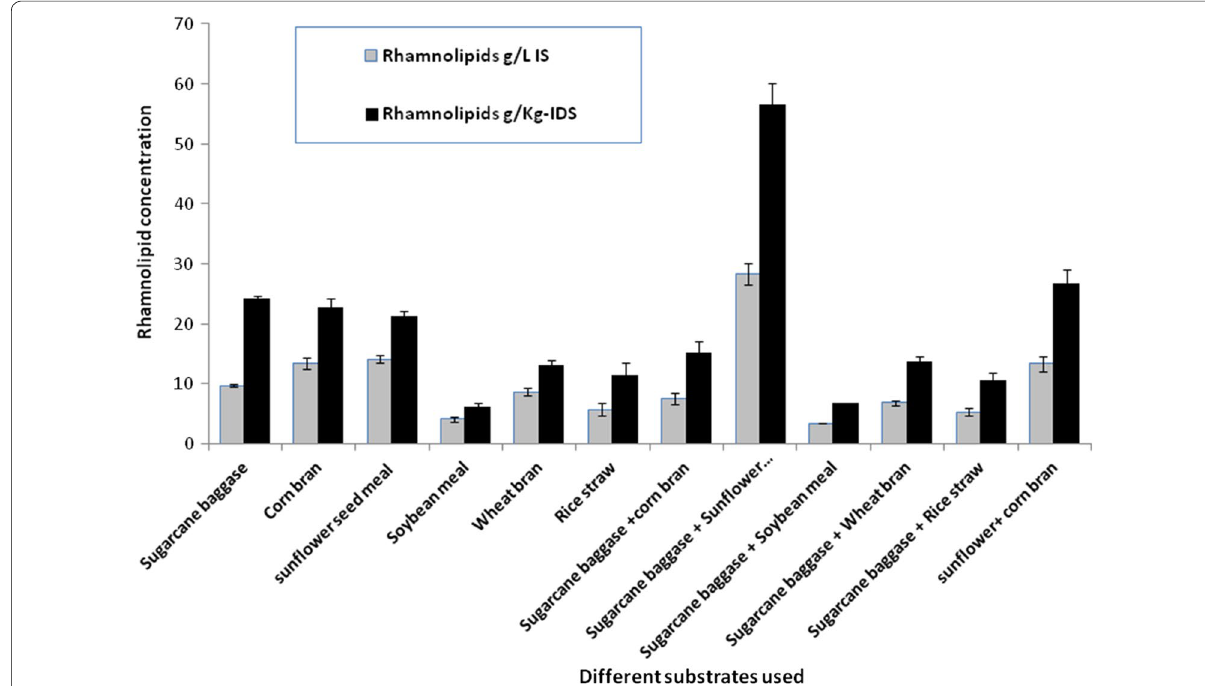
Fig. 1 Effect of different solid substrates on RL production by P. aeruginosa 15GR in SSF after 6 days of incubation at 30 °C. Values plotted are the means of triplicate results while error bars indicate the standard deviation of the